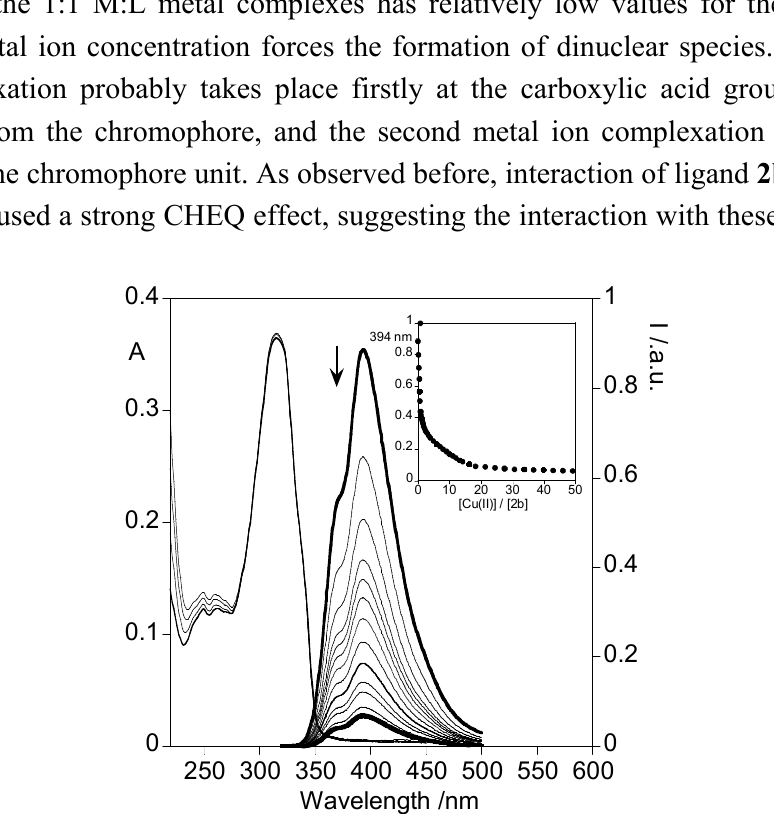
SO ) in absolute ethanol. ([ 2b ] = 1.30E-5 M, T = 298 K, λ 3 2 2 Inset: normalized emission at 394